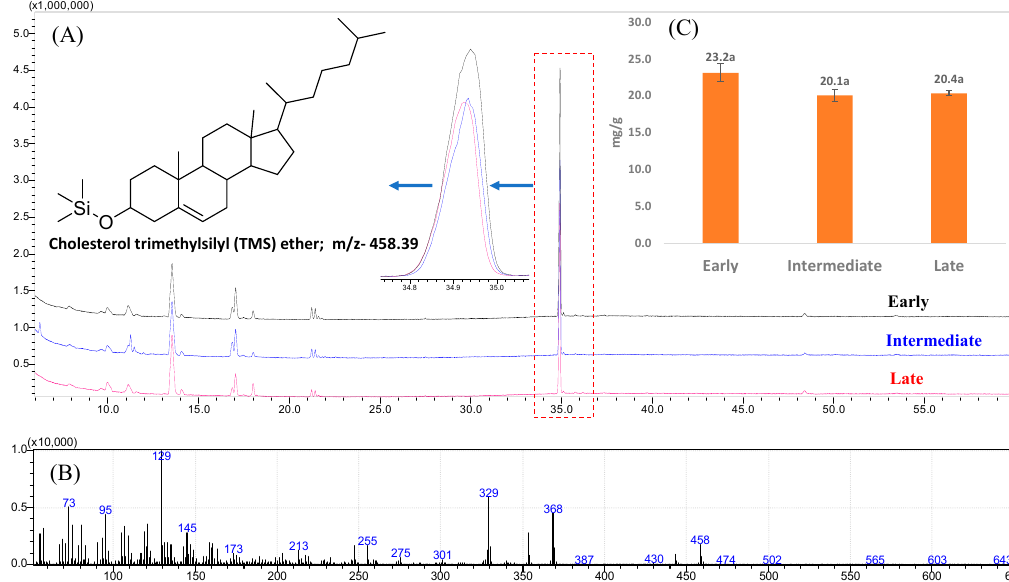
Figure 7. ( A ) The gas chromatography–mass spectrometry (GC–MS) total ion chromatogram (TIC) of cholesterol (retention time: 34.934 min). ( B ) The GC–mass spectrum of cholesterol from egg yolk. ( C ) Content (mg/g egg yolk; fresh weight) of cholesterol in the yolks from early, intermediate, and late-age laying hens. The values are the mean ± standard deviation of six independent experiments. The same letters (a; in data labels) represent differences is not significant ( p > 0.05) between early, intermediate, and late-age laying hens.